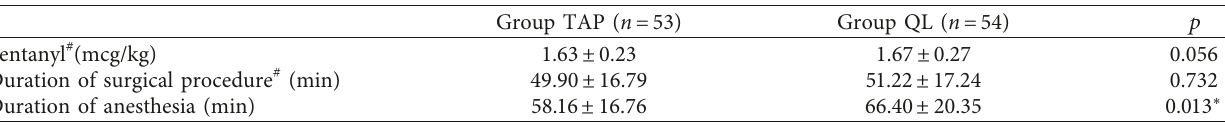
Table 2: Fentanyl consumption, duration of surgical procedure, and anesthesia (min).